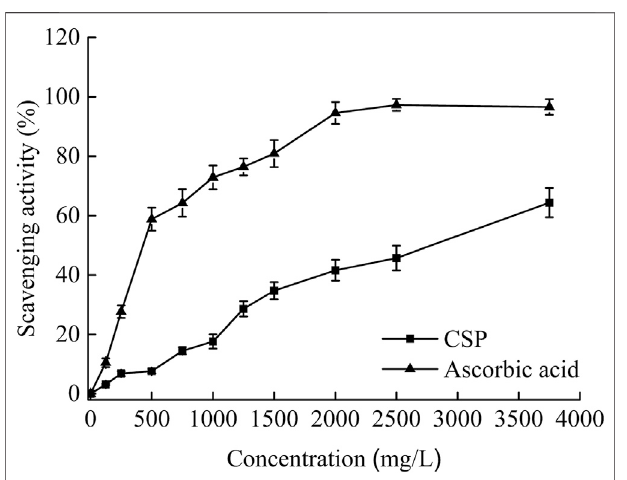
FIGURE 3 | Scavenging effects on superoxide anion radicals of CSP.